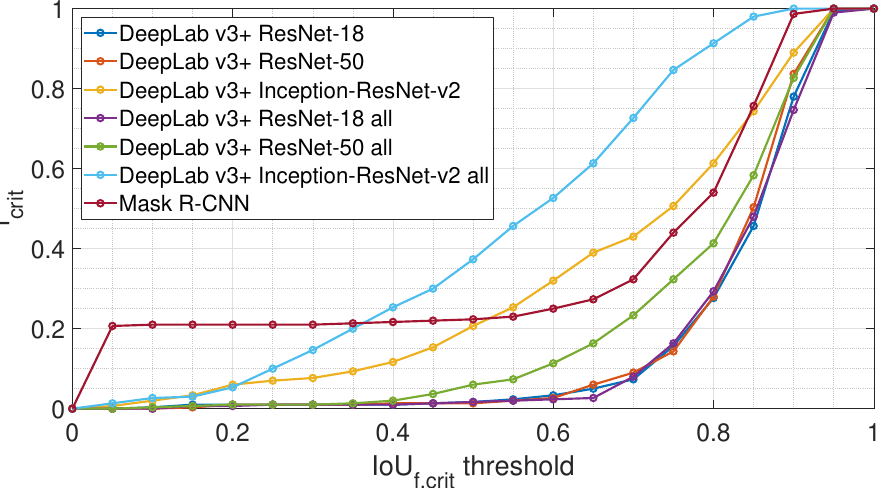
Figure 5. i crit Curves over incremental IoU f,crit thresholds for instance flame segmentation. For each segmentation network we sample i crit at 21 IoU f,crit levels from 0.0 to 1.0. At increasing IoU f,crit , the fraction of critical Images i crit rises, resulting in a characteristic curve for each segmentation